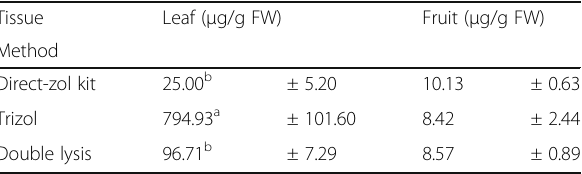
Table 1 Yields of RNA isolated from strawberry leaves and fruits using three dependent methods Tissue Leaf ( μ g/g FW)